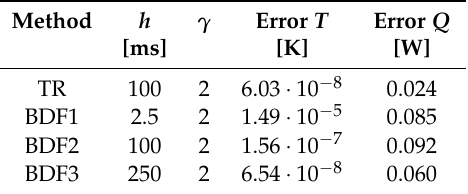
Table 18. Synchronous motor: High-precision configuration of the DAE integration